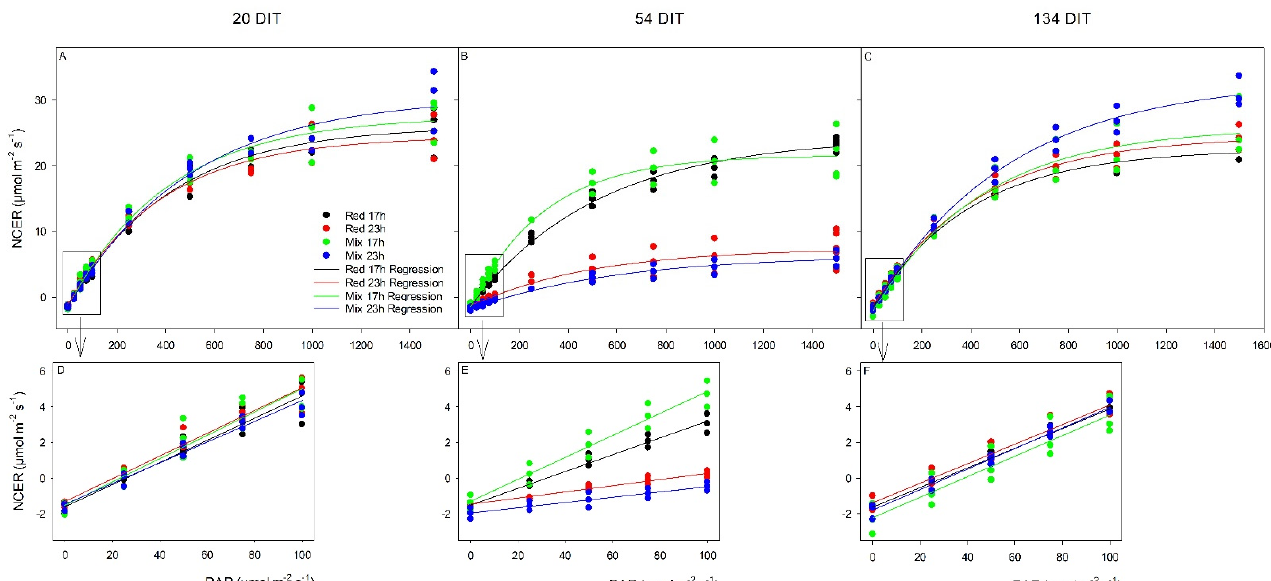
error of the mean of n = 3. Letter groups (A, B, C) represent significant differences within a panel between the lighting treatments at a specific data collection period at p < 0.05.